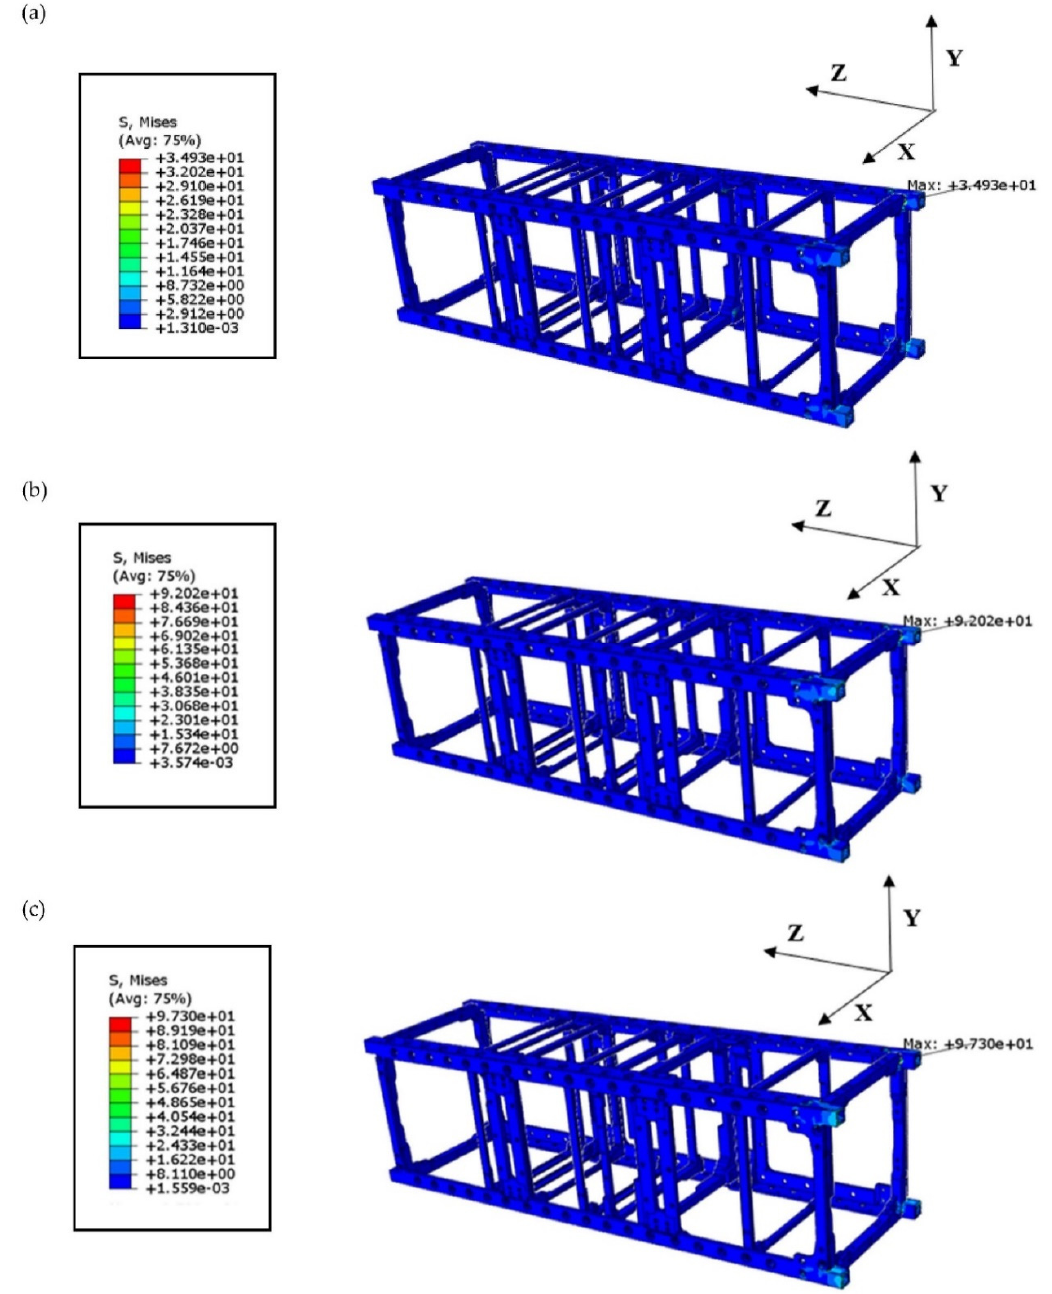
Figure 14. Maximum stress ( MPa ) in frame: ( a ) Case A; ( b ) Case B; ( c ) Case C.